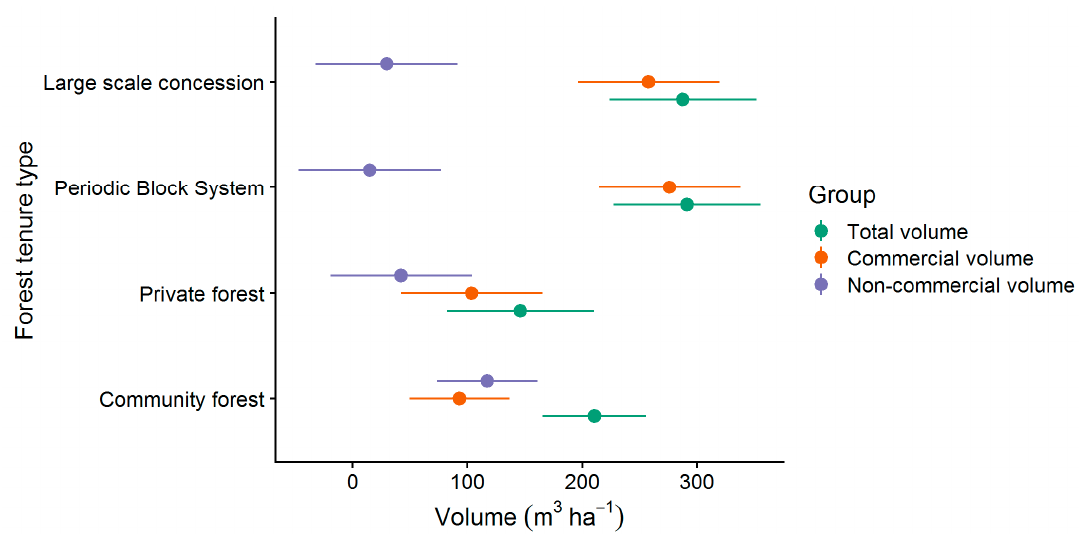
Figure 4. Commercial and non-commercial volumes and 95%-confidence intervals of the present forest tenure types.